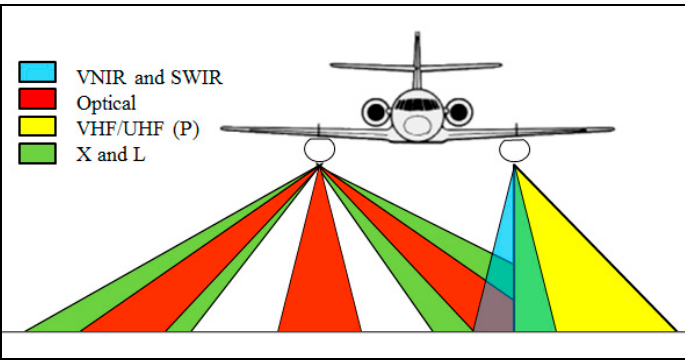
Figure 3. SETHI—possible geometries of imagery for both optical and radar sensors.